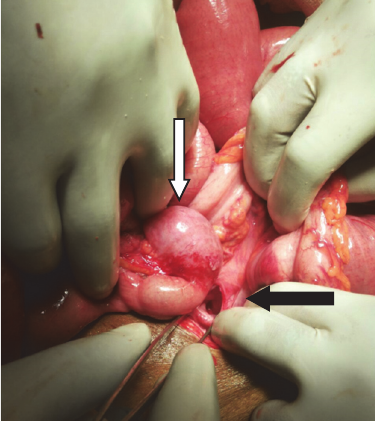
Figure 1: The hernia defect located lateral to sigmoid colon in the left paracolic gutter (black arrow); the bowel loop after reduction (white arrow).